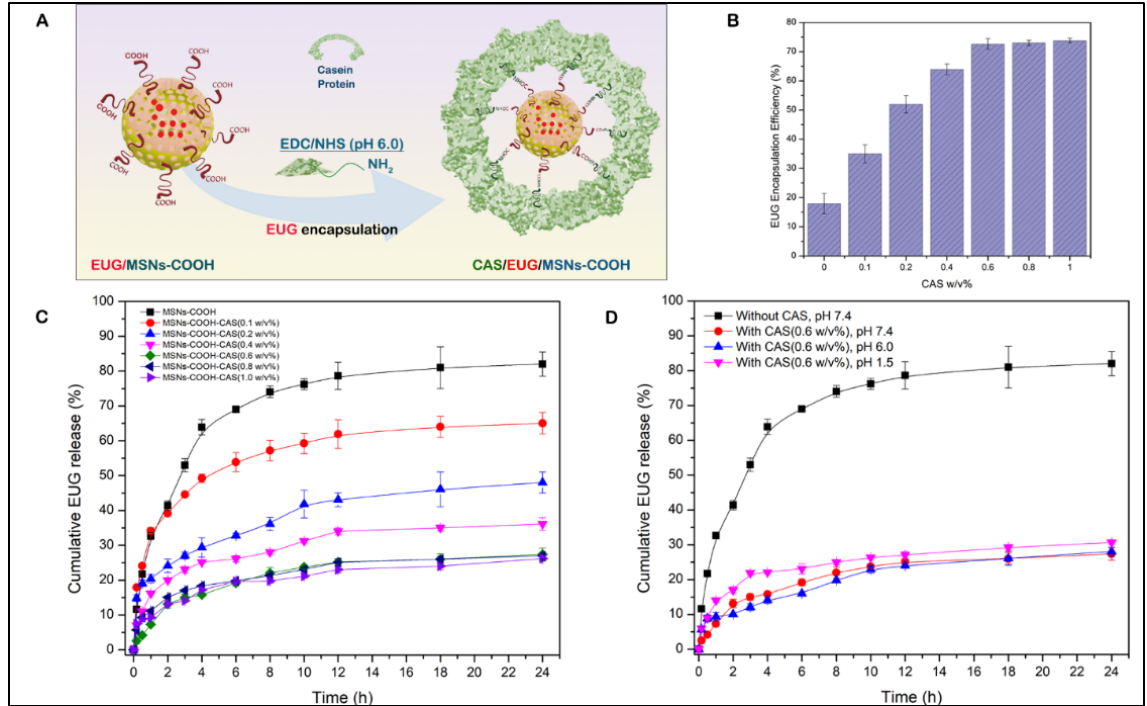
Figure 8. ( A ) Conjugation of casein to the carboxy-functionalized MSN particles after NHS/EDC activation, ( B ) The encapsulation efficiency of eugenol (EUG) for 24 h along with varying w / v % of casein as a capping layer for EUG-loaded MSN nanoassemblies, ( C ) Cumulative release (%) profiles of EUG from EUG/CAS-MSNs–COOH at different w / v % of casein at pH 7.4, RT, to obtain the effect of casein capping layer for EUG release over 24 h. The black curve represents EUG release profiles without any casein conjugation to the EUG/MSNs–COOH. ( D ) Cumulative release (%) profiles of EUG from EUG/CAS-MSNs–COOH (0.6 w / v % casein) at different pH conditions, pH 7.4 (Red curve), pH 6.0 (Blue curve), pH 1.5 (Pink curve). The black curve represents EUG release pro- files without any casein conjugation to the EUG/MSNs–COOH at pH 7.4, RT. Each data point rep- resents the mean of the experiments performed in triplicate and their corresponding standard de- viation.